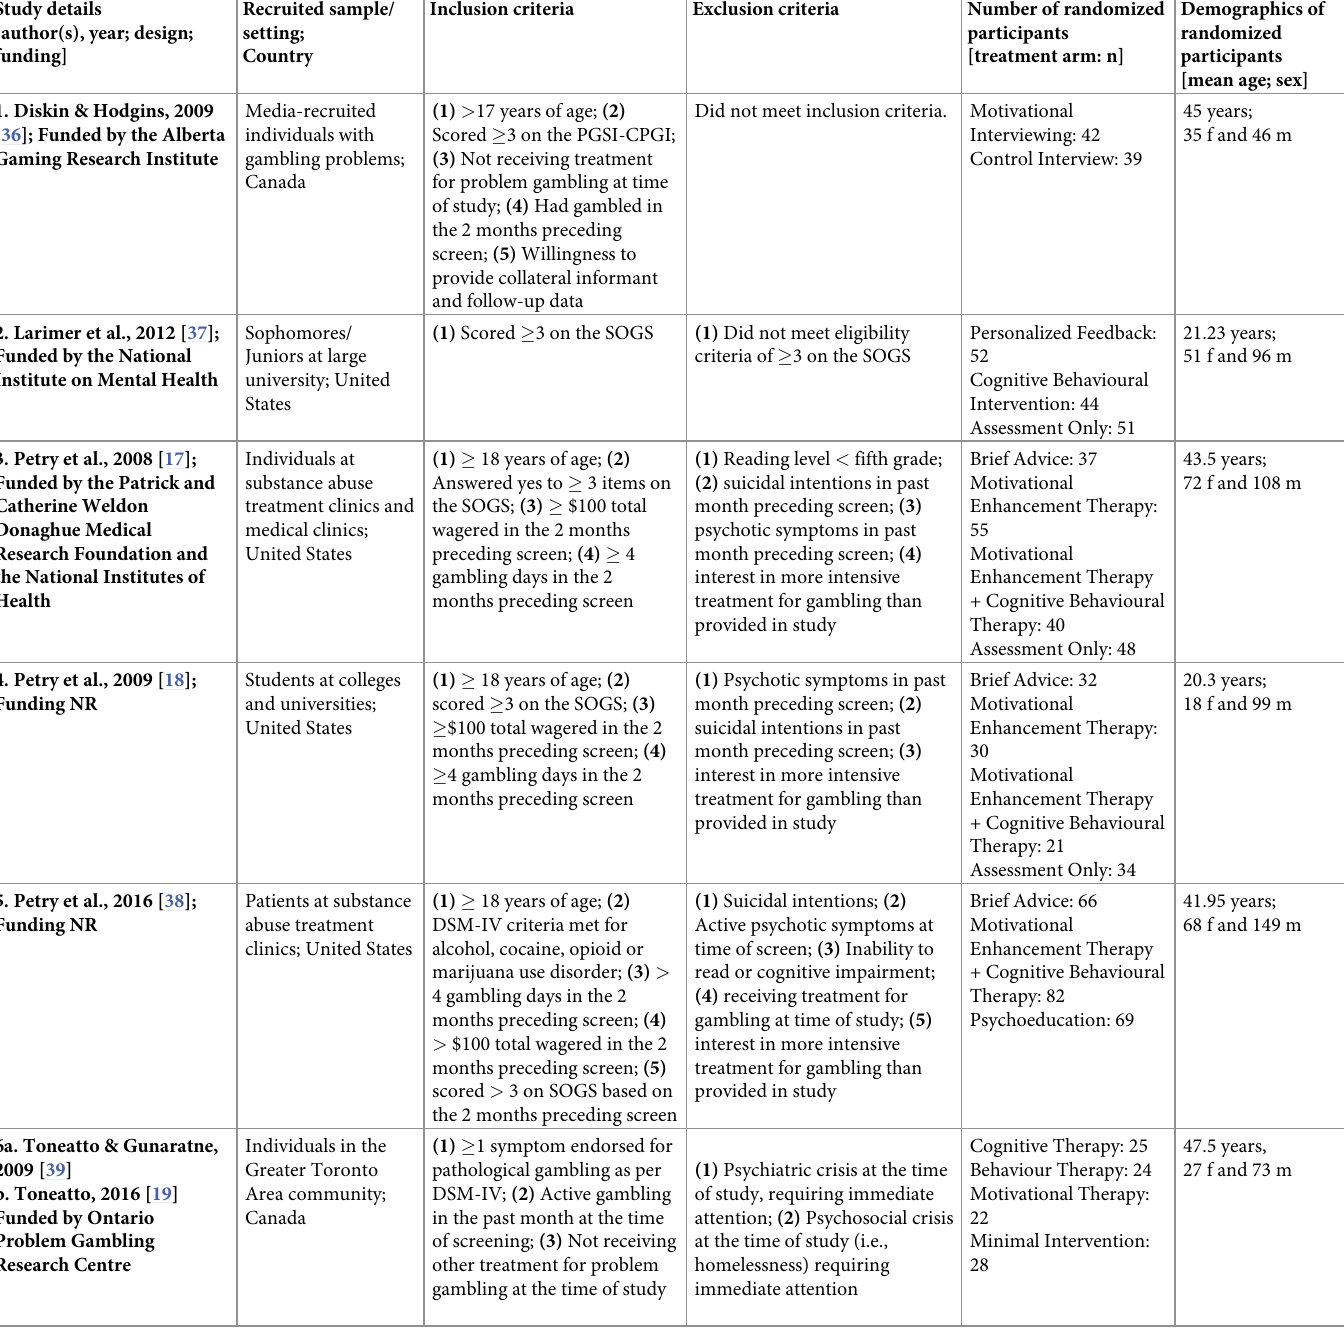
Table 1. Features of included randomized controlled